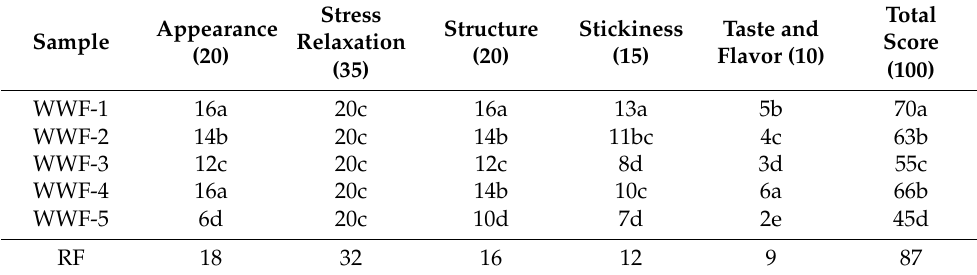
The scores were reported as mean values from five panelists. Within each column, values followed by different